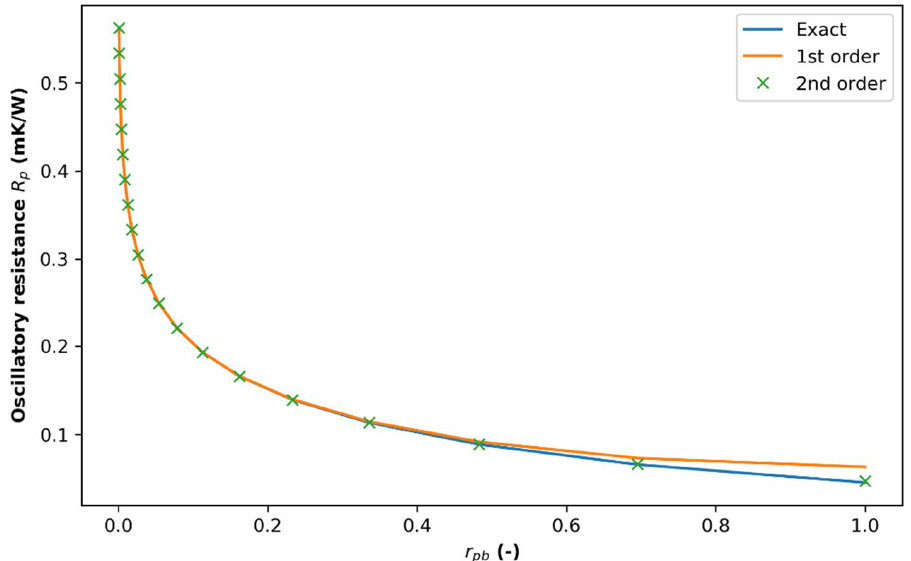
Energies 2021 , 14 , x FOR PEER REVIEW 23 of 26